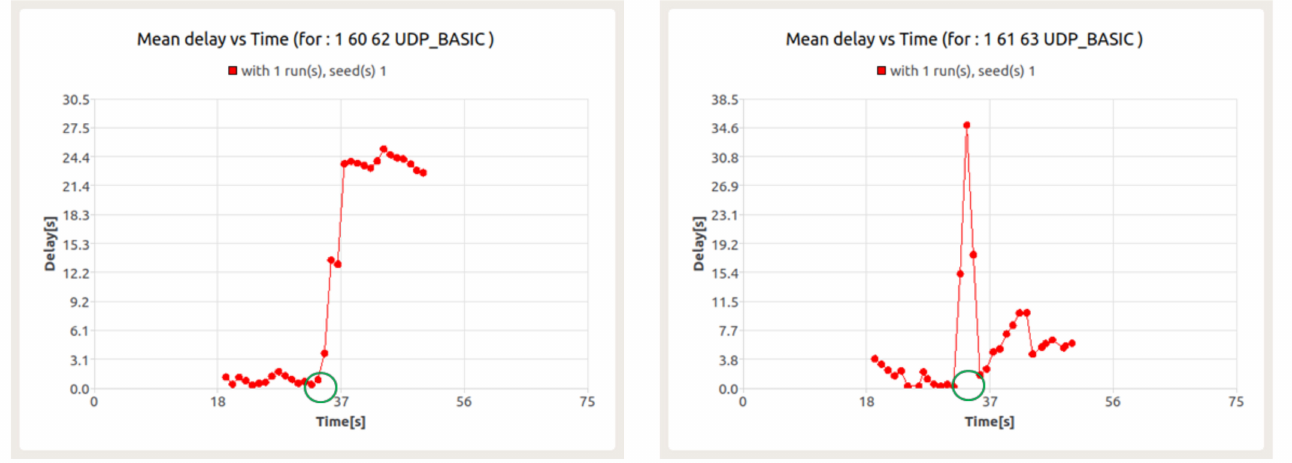
Figure 21. Delay for UDP session in the presence of background traffic between nodes 60–62 ( left ) and between nodes 61–63 ( right ) with node 60 as a